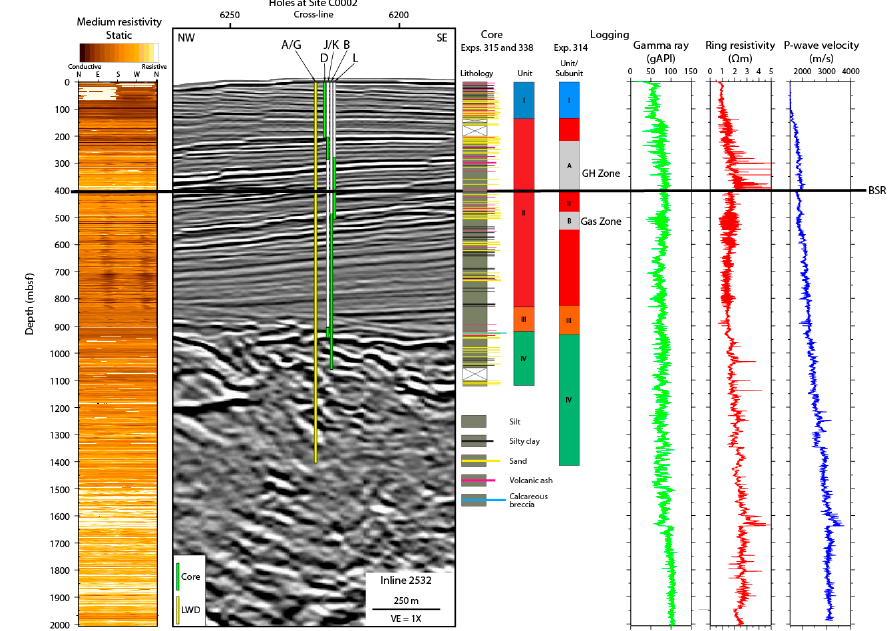
Figure 2. Core-log-seismic integration at Site C0002 showing composite medium button static resistivity, composite core lithology, logging units and composite logging-while-drilling (LWD) data. The BSR occurs at ~400 mbsf. High resistivity spikes are present above the BSR. Subunit A was noted to have high gas hydrate occurrences and Subunit B was a gas saturated zone. Figure modified from [26].